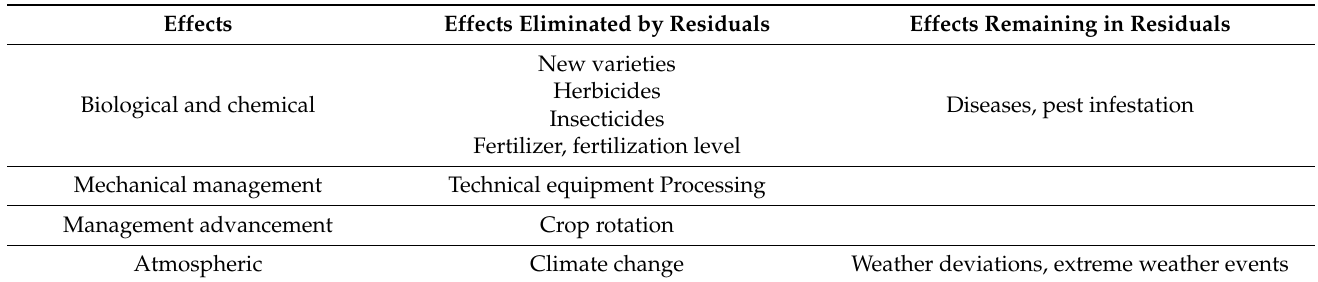
Table 4. Overview of the effects on the temporal yield development and the effects eliminated by calculating